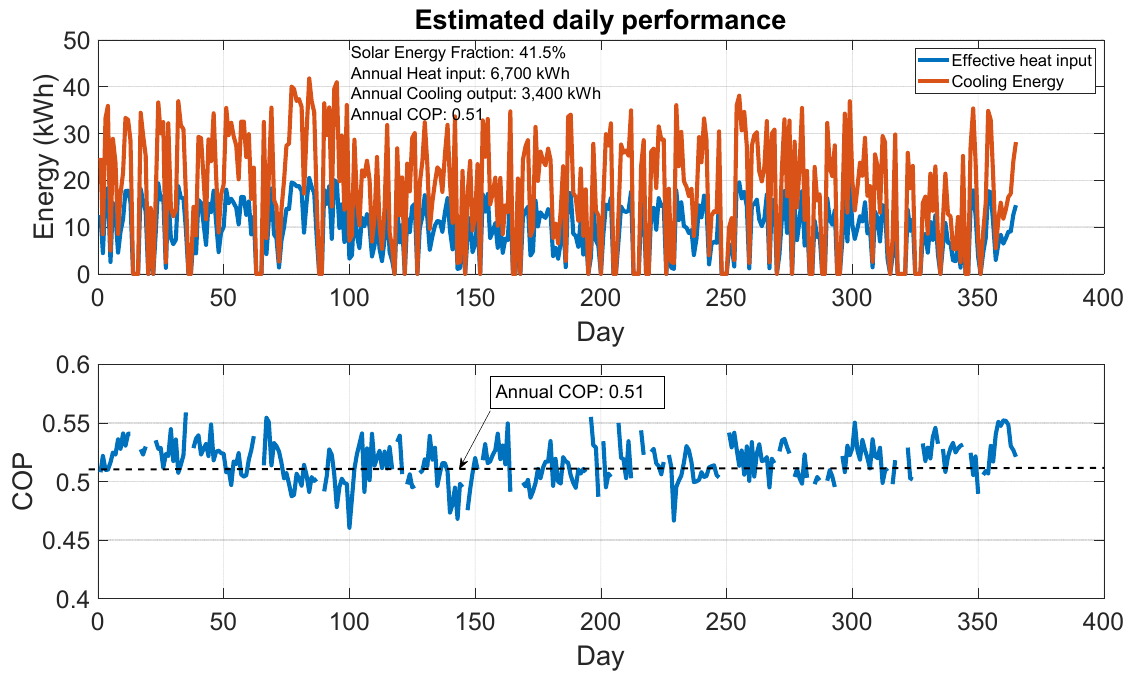
Figure 8. Daily performance throughout the year with 9.8 m 2 evacuated tube solar collector (ETSC).